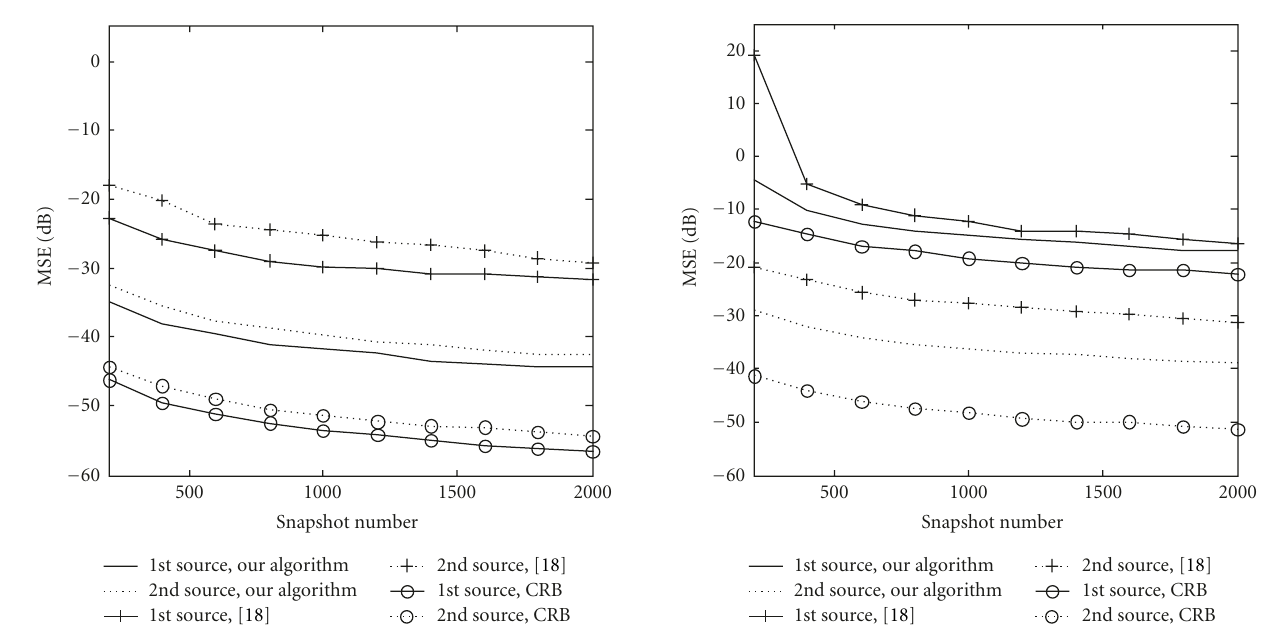
Figure 7: Estimation MSE of the azimuths versus snapshot number.